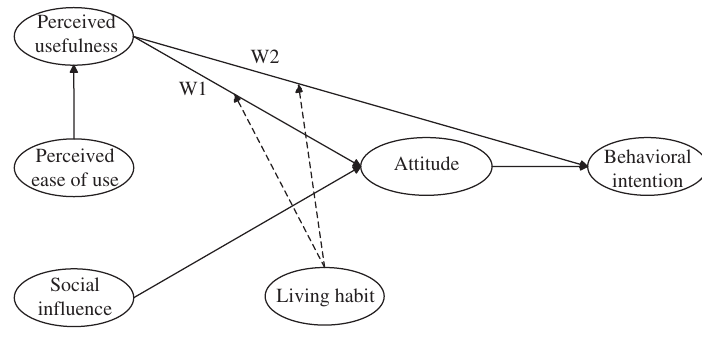
Figure 4. Control Variable